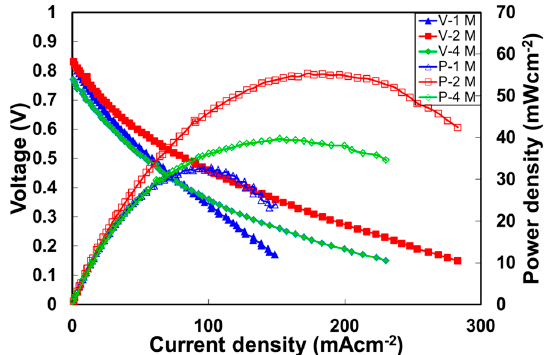
Figure 7. DMAFC performance with different methanol concentrations in 6 M KOH at 60 °C using CL-QPVA/GO-Fe 3 O 4 composites prepared with the magnetic field. Cathode: humidified oxygen with a flow rate of 100 mL·min − 1 . GDEs: catalysts of 6 mg·cm − 2 Pt-Ru/C for the anode and 5 mg·cm − 2 Pt/C for the cathode on MPL-free carbon cloth.